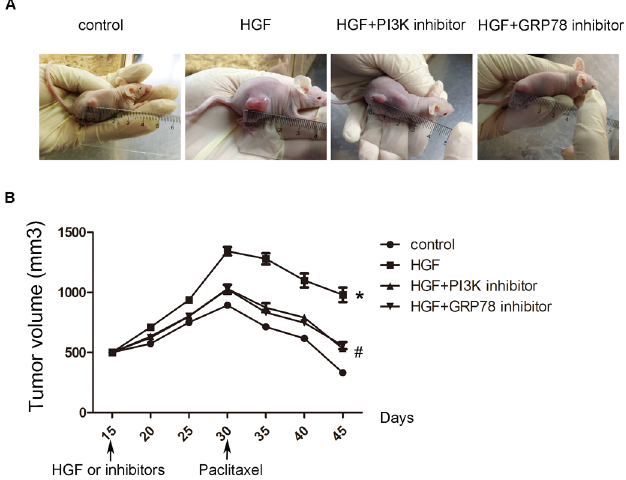
* P < 0.05 vs control group, # P < 0.05 vs HGF